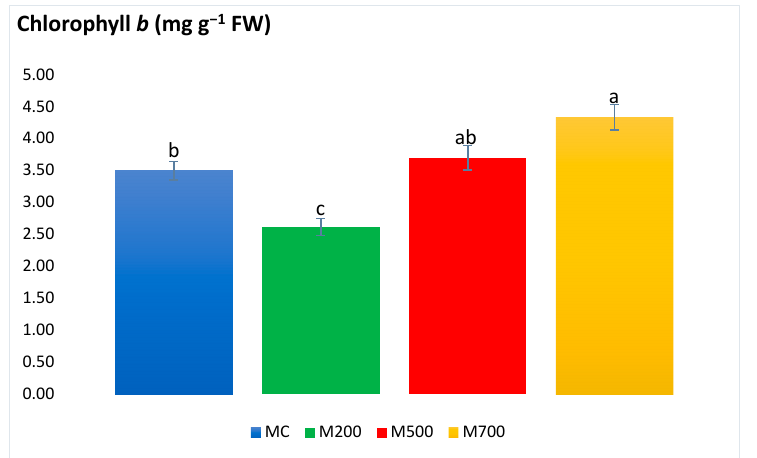
Figure 4. Concentration of chlorophyll b in the leaves of Mis-B cultivar cultivated in soils with gra- dient T.E. concentrations (MC, M200, M500, M700). Values are presented as mean ± SE. Di ff erent le tt ers refer to signi fi cant di ff erences between plants (Tukey HSD test, n = 6, p ≤ 0.05). Lowest carotenoid contents were obtained in M200 (0.11 ± 0.004 mg g − 1 FW), with 30% decrease compared to M700 (Figure 5). Otherwise, no signi fi cant di ff erences were detected between the treatments.